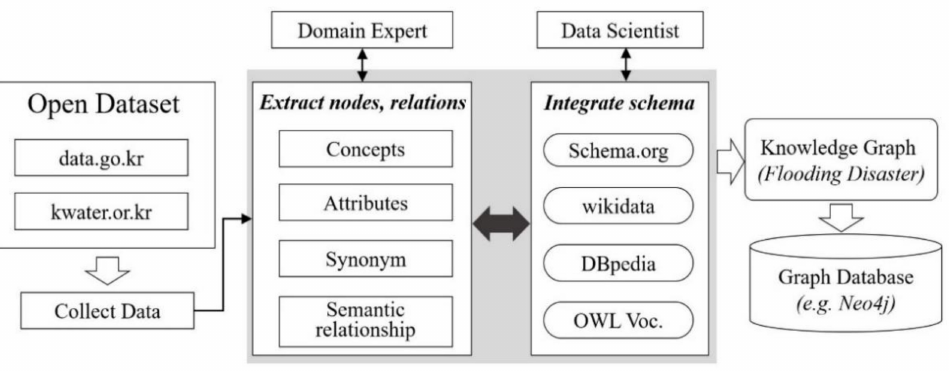
Figure 1. Proposed model.